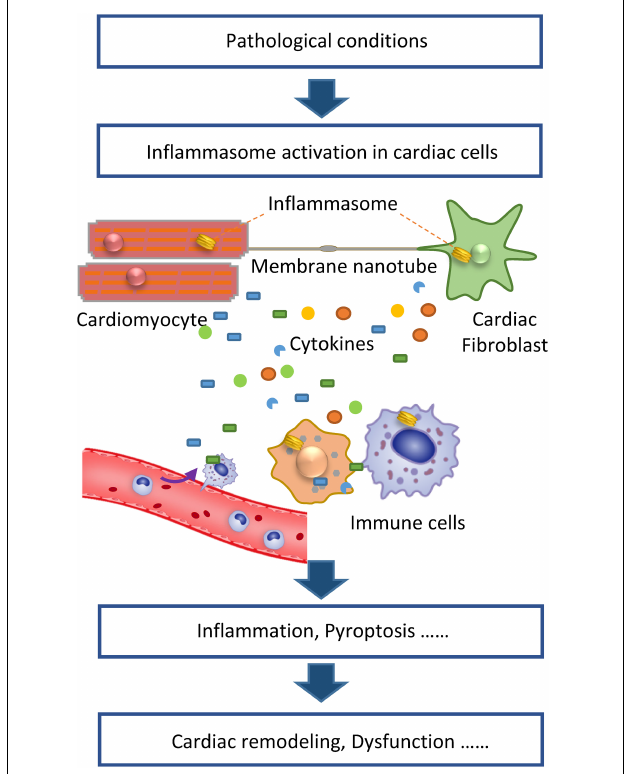
FIGURE 1 | Inflammasome activation in cardiac cells initiates cardiac inflammation to promote heart failure. Under pathologic conditions, inflammasomes in cardiomyocytes, and fibroblasts are activated. Activated inflammasomes cause the release of proinflammatory cytokines from various cell types, collaboratively contributing to the inflammatory cascade. Besides cytokines, membrane nanotubes also mediate the transport of activated inflammasomes, thereby propagating inflammatory injury. The resultant cardiac inflammation causes pathologic cardiac remodeling, cell death, and